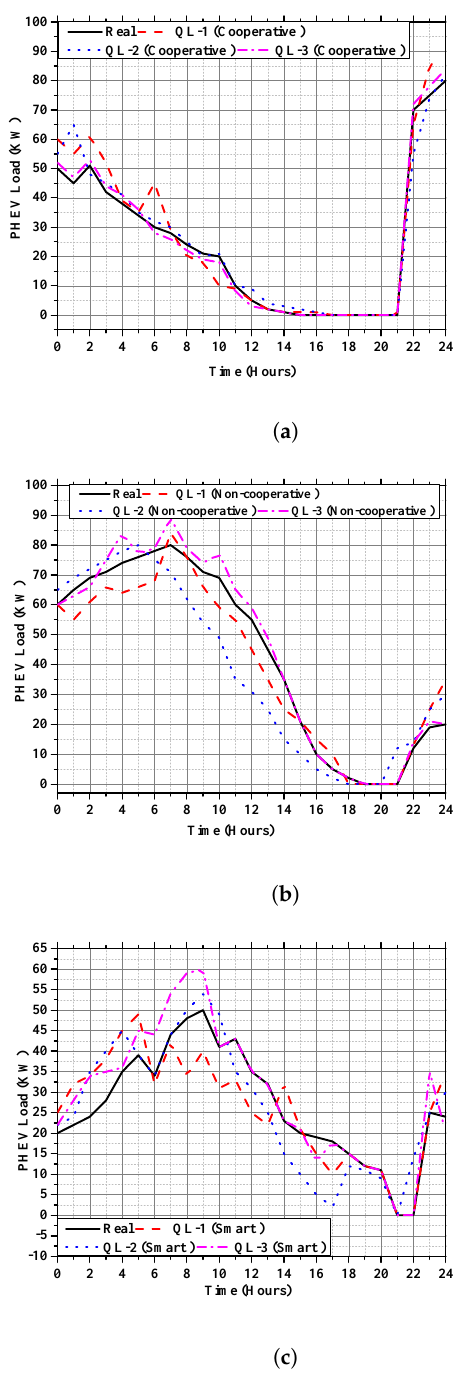
Figure 10. QL sensitivity analysis for the three PHEV charging (Cooperative, Non-cooperative and Smart) (kW). ( a ) QL sensitivity analysis for cooperative PHEV charging (kW). ( b ) QL sensitivity analysis for non-cooperative PHEV charging (kW). ( c ) QL sensitivity analysis for smart PHEV charging